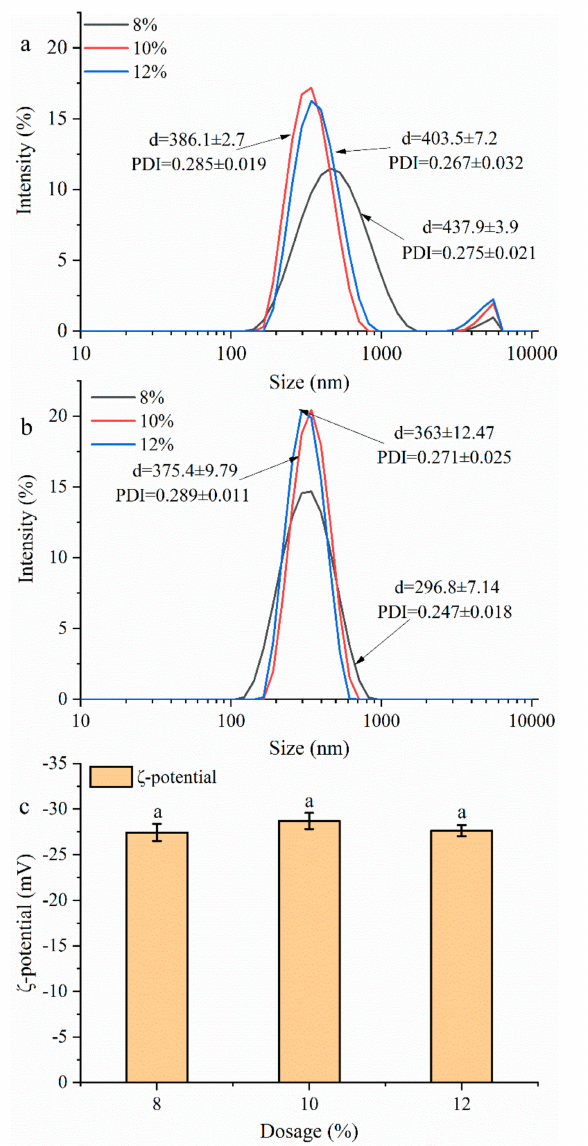
Figure 3. The size of GNPs cross-linked by di ff erent genipin dosages (8–12 wt%) that diluted in ( a ) de-ionized water and ( b ) 1% SDS. ( c ) ζ -Potential of GNPs cross-linked by di ff erent genipin dosages (8–12